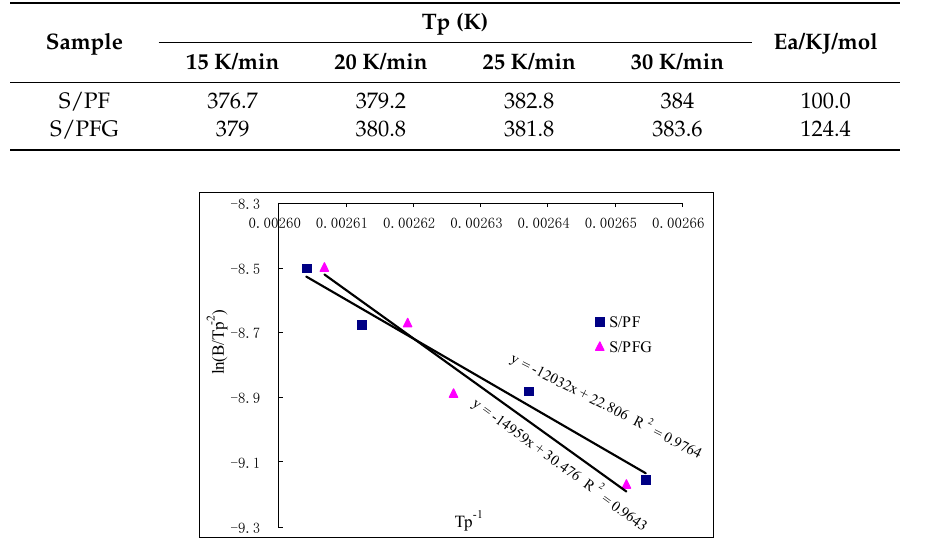
Figure 4. The relationship between 1/Tp and ln( β /Tp 2 ) for samples S/PF and S/PFG.